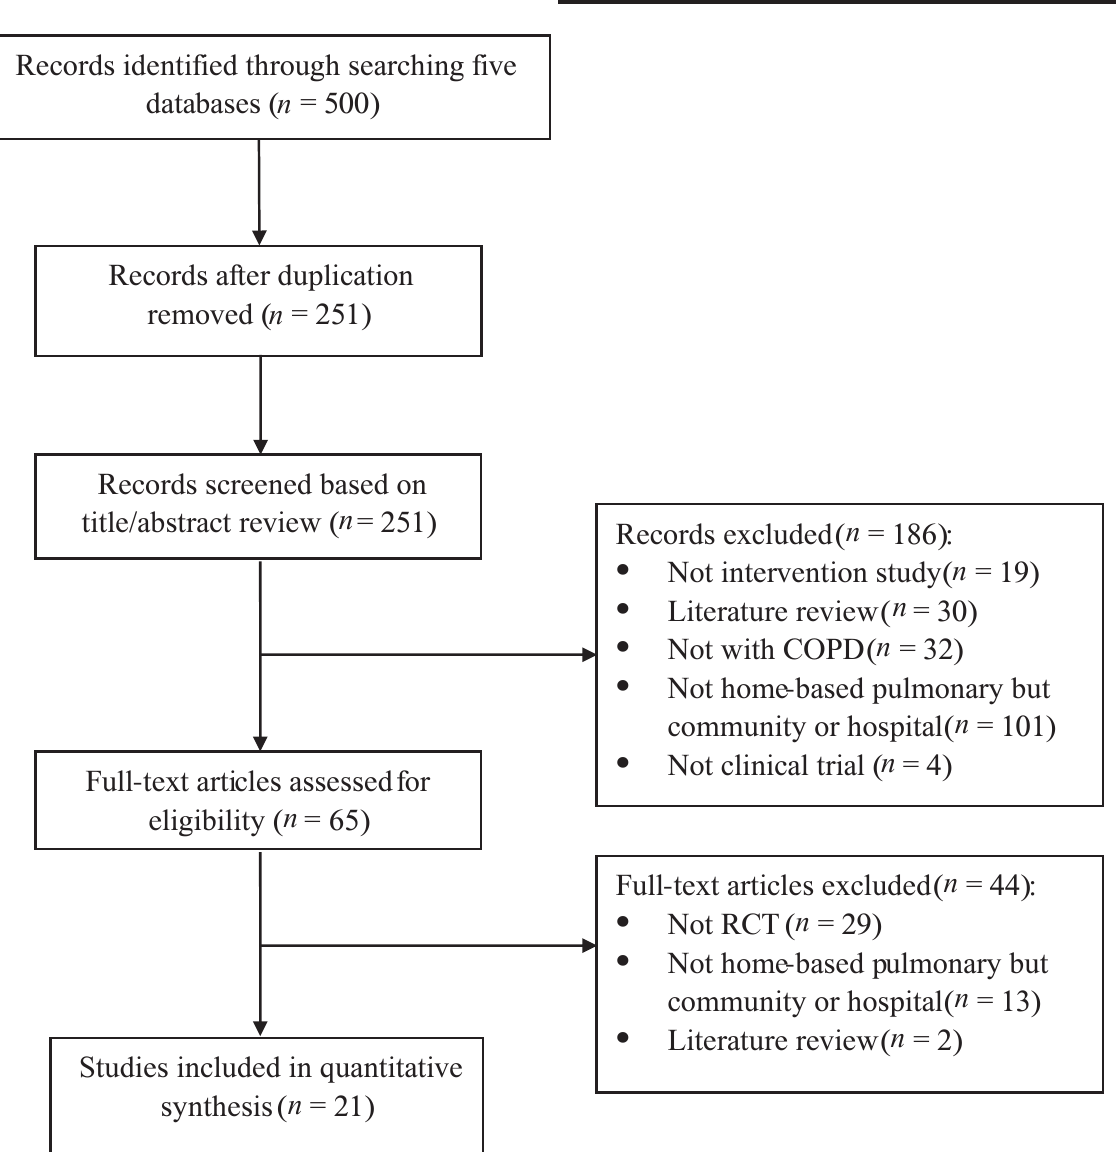
Figure 1. PRISMA